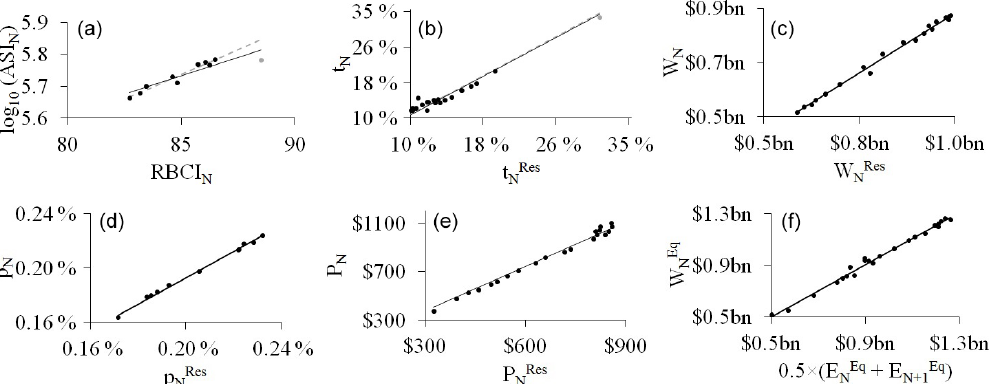
Figure 1. Fits of the linear regressions for (a) the average sum insured and the real building cost index, (b) the average premium rate between the residential and the homeowner lines of business, (c) the take-up rate between the residential and the homeowner lines of business, (d) the average premium amount between the residential and the homeowner lines of business, (e) the total written premium amount between the residential and the homeowner lines of business, and (f) the written and the earned premium amounts. Grey points on (a) and (c) represent the extreme values, affecting the linear regression from the solid black line to the dashed grey line, when removed. Financial values are in 2015 US dollars.